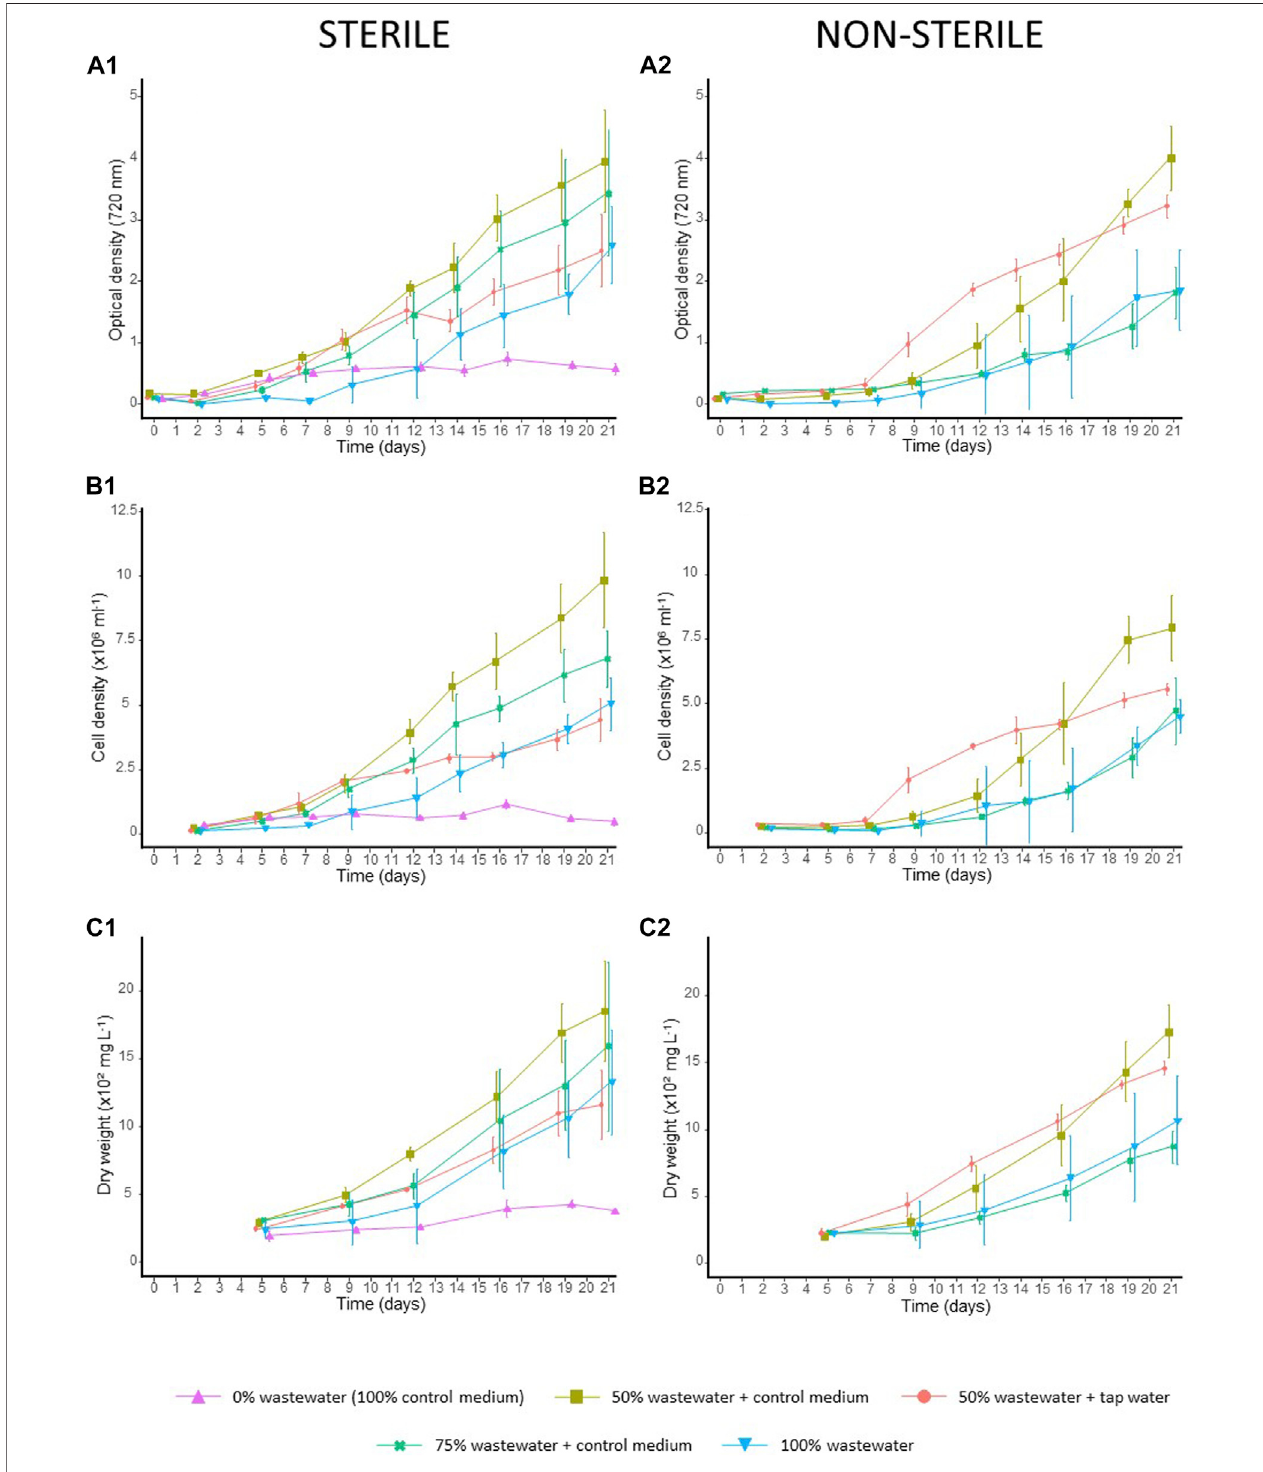
FIGURE 4 | Growth curves of C. sorokiniana on non-/sterilized wastewater dilutions. Algae growth was monitored for all sterile conditions through (A1) optical density (720 nm) measurements (starting from day 0), (B1) cell counts (starting from day 2) and (C1) dry weight measurements (starting from day 5) throughout the 22- days growing period. Likewise, algae growth in non-sterilized medium was monitored by assessing (A2) optical density, (B2) cell count and (C2) dry weight. The results are given as the average of three values, and whiskers delineate the standard deviation.